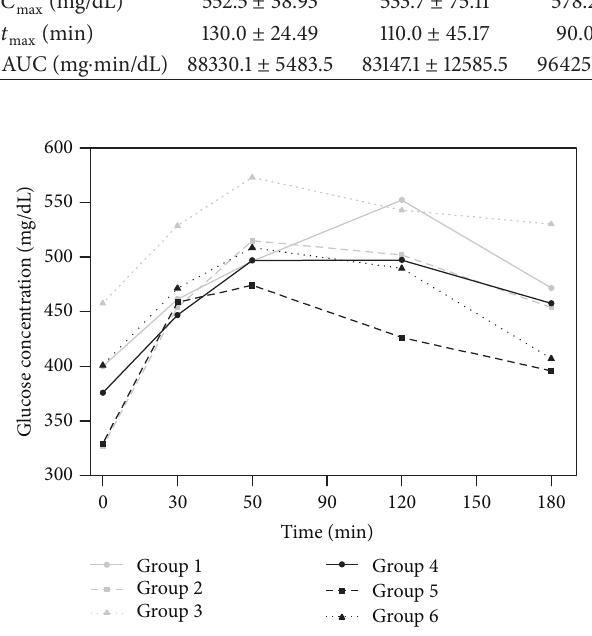
Figure 2: Insulin concentrations after administration of metformin (30 mg/kg) in the 6 groups studied. Group 1: control standard; group 2: oral metformin; group 3: oral metformin with Plantago ovata husk; group 4: control supplemented; group 5: oral metformin with supplemented chow; group 6: oral metformin with Plantago ovata husk with supplemented